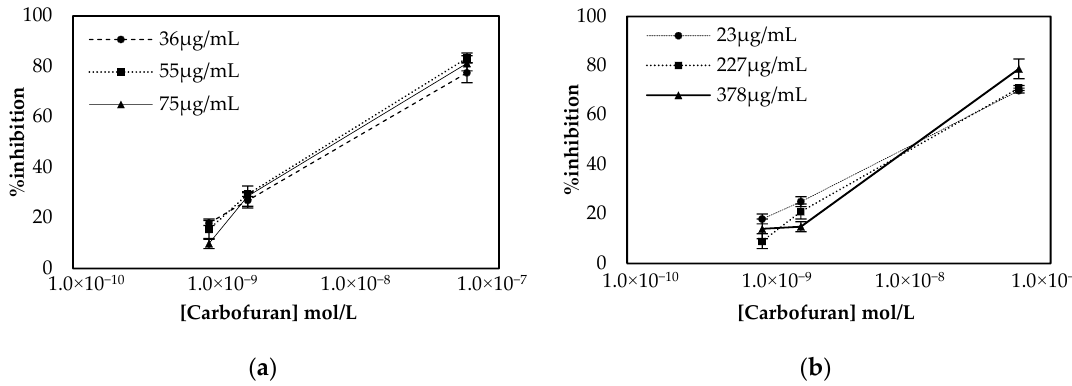
Figure 3. Optimization of enzyme concentration for sensors fabricated following the ( a ) multistep and ( b ) one-step approaches. Percentage inhibition of the enzyme was calculated following incubation of the biofunctionalized sensor with three different concentrations of carbofuran and recording the current amperometrically at an applied potential of +250 mV. All measurements were taken in triplicate.